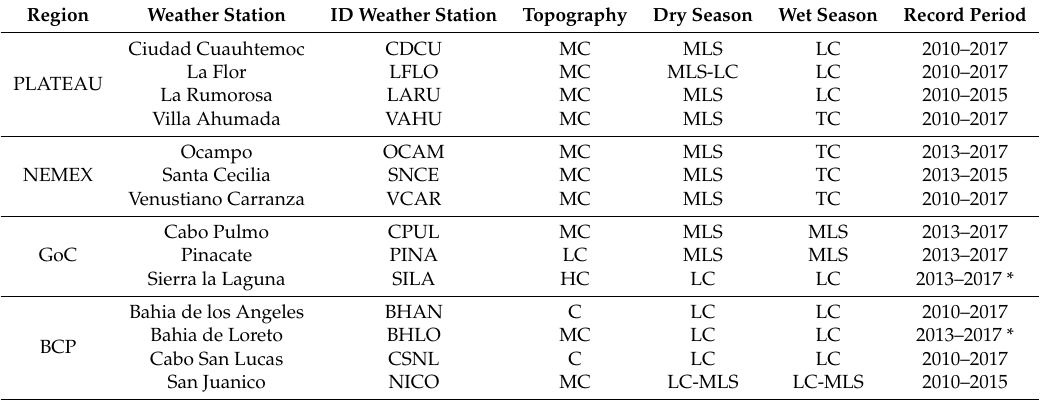
Table 1. Classification of the sites by topography and weather systems.